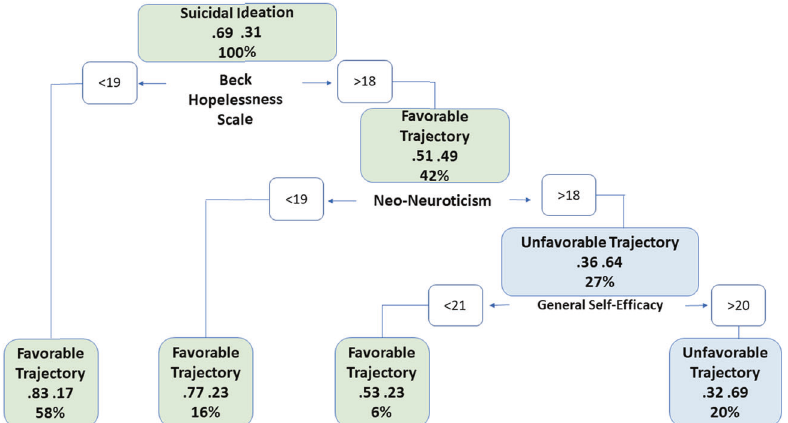
Fig. 4 A classi fi cation tree predicting membership to the two suicidal ideation trajectories using the three strongest predictors of suicidal ideation in older adults with major depression randomly assigned to “ engage ” or problem-solving therapy. The classi fi cation tree offers a clinical decision rule for identifying membership to either the favorable or the unfavorable trajectory of suicidal ideation during psychotherapy. At each box, participants are classi fi ed into either the left or right succeeding box based on the decision rule displayed. Green boxes signify higher probability to have a favorable trajectory of suicidal ideation and blue boxes signify a higher probability to have an unfavorable trajectory of suicidal ideation. The fi nal prediction of trajectory membership is determined by the fi nal box a participant falls into. Each box presents the proportion of total participants who fall into that box (bottom proportion), as well as the proportion of who belongs to the favorable and the unfavorable trajectories (left and right proportions in center of box, respectively), irrespective of the box prediction. For example, the fi rst decision rule split indicates that 58% of participants had hopelessness scores <19; 83% of these participants had favorable trajectories, while 17% of these participants had unfavorable